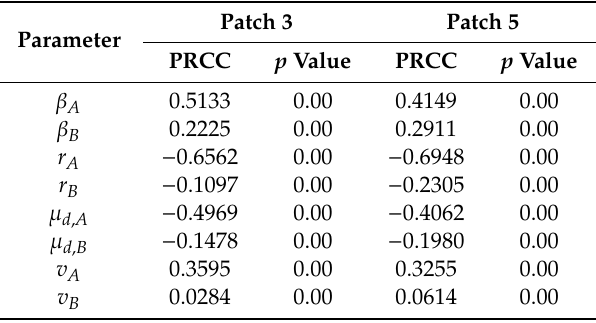
Table 3. Partial rank correlation coe ffi cient (PRCC) between the likelihood of virus translocating to Patch 3 or Patch 5 and core parameters in both flocks.